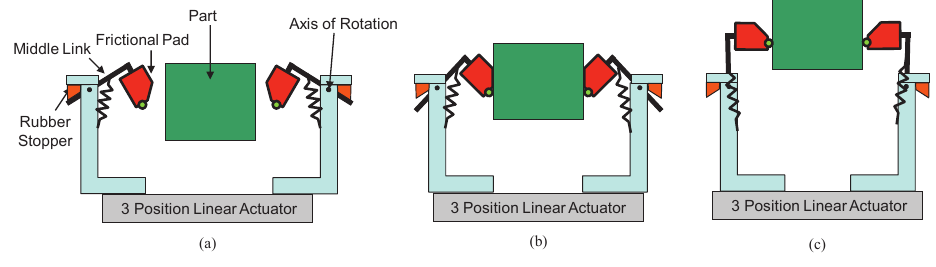
Figure 3. Parallel jaw gripper with changing joints.